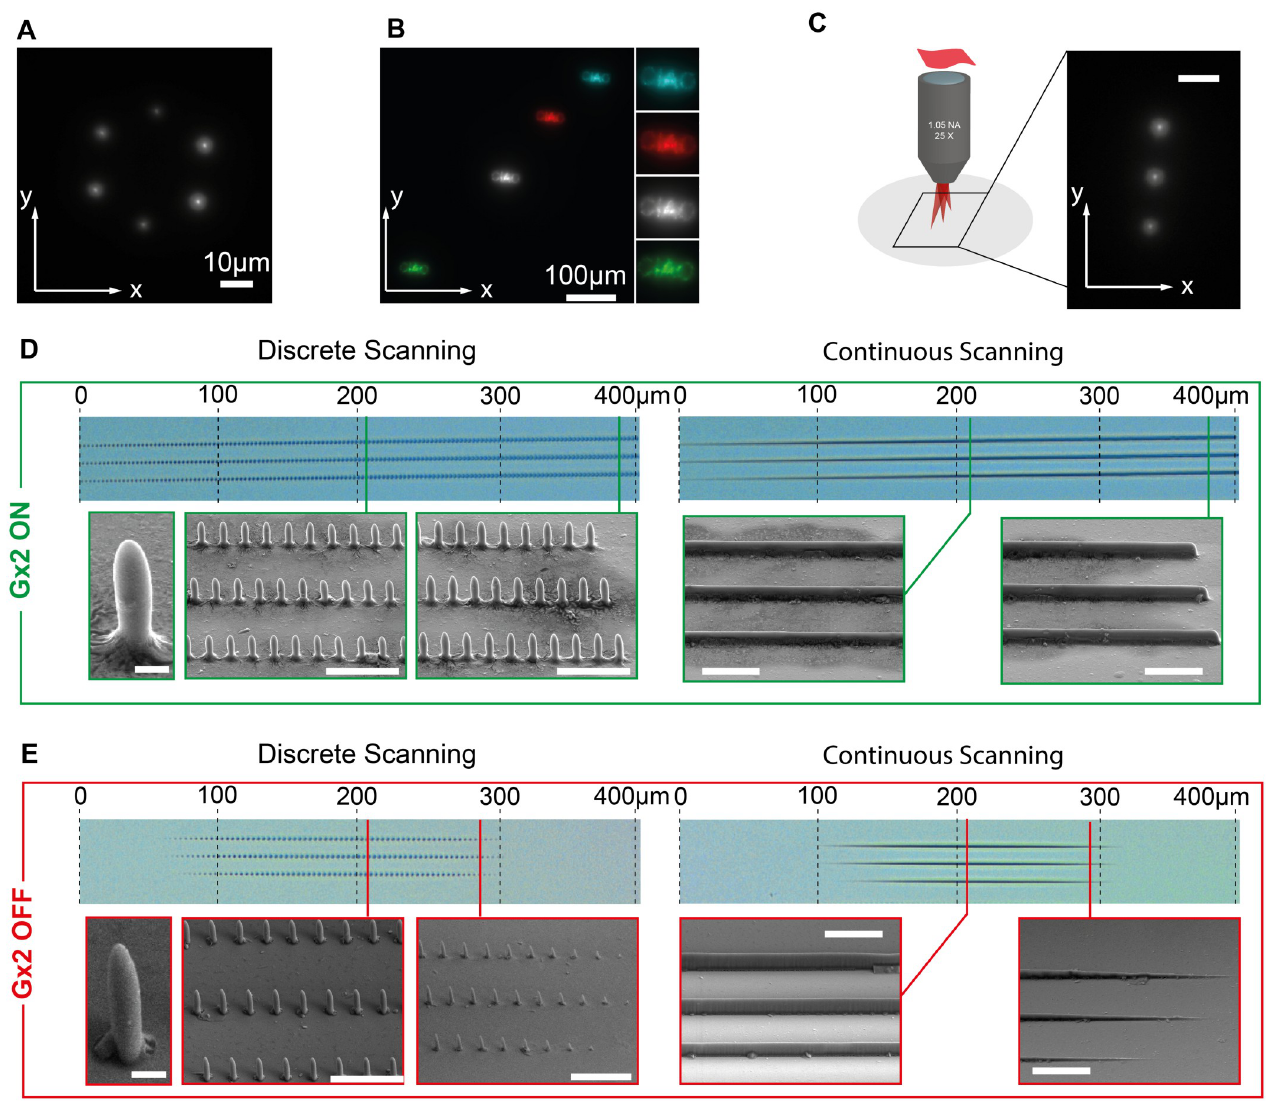
Fig 4. Holographic projection and polymerization. (A) Multiple spots generated with the SLM system arranged on the vertex of a hexagon. (B) Complex shape projection on the sample plane shifted in four different positions in the WFOV using the three mirrors scanhead (overlay in false colors of different position). Insets on the right are 2X zooms of the projected patterns. (C) (left) Schematic representation of the writing configuration with the simultaneous projection of three polymerizing spot. The inset on the right shows the fluorescence excited in a drop of fluorescein by the three spots, the scalebar is 10 μ m. (D) Array of pillars (left) and lines (right) polymerized by discretely and continuously scanning the hologram in panel C with the beam drift compensation implemented by Gx2 enabled. The position of the Scanning Electron Microscope details (bottom rows) are highlighted in the optical microscope image (top) by the vertical lines. Scalebars in the SEM images are 1 μ m for the single pillar image and 10 μ m for the others. (E) As in panel (D), without enabling the beam drift compensation implemented by